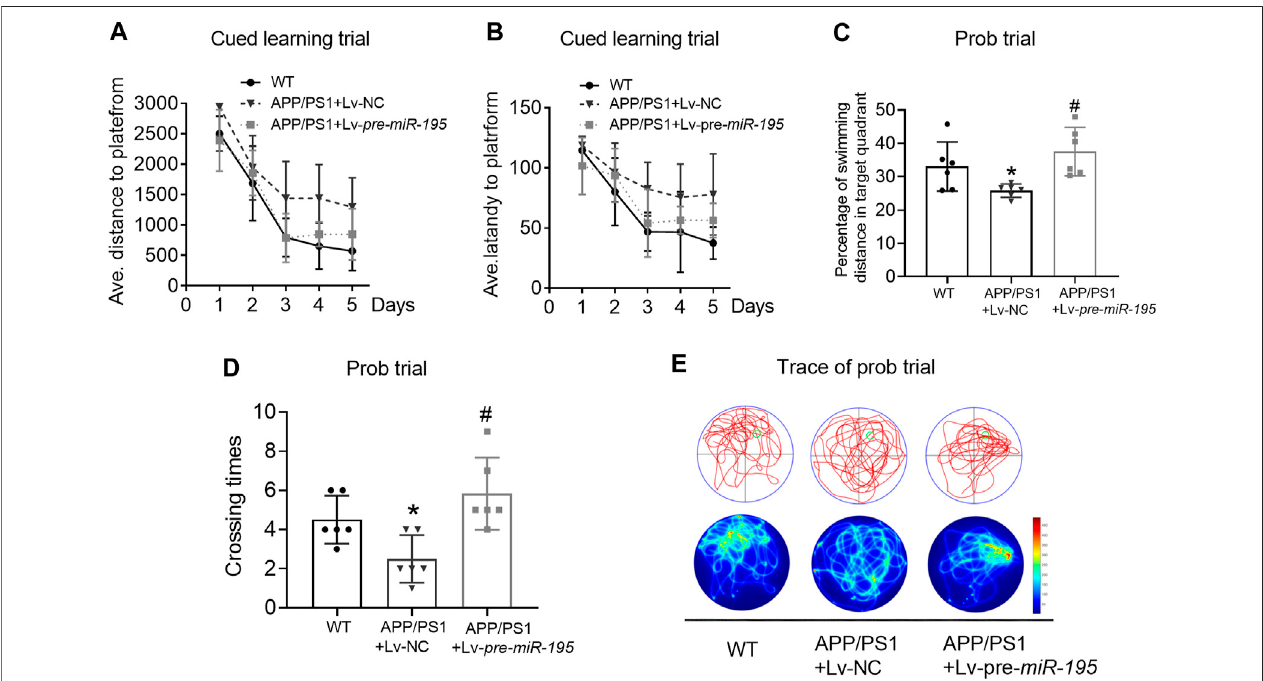
FIGURE5| MiR-195 attenuatesthedeclinedlearningandmemoryinAPP/PS1miceafterbraininjectionofLv-pre- miR-195 for3M (A) Averagedistancetoplatform after Lv- pre-miR-195 injectionfor3M. n (cid:2) 6forWT,Lv-NCandLv-pre -miR-195 group (B) Averageescape latencytoplatformaftertreatmentofLv-pre -miR-195 for3M. n (cid:2) 6 for WT, Lv-NC and Lv- pre-miR-195 group (C) Percentage of swimming distance in the target quadrant relative to the total distance of the pool during probe trial. * p < 0.05vs.WT, n (cid:2) 6. # p < 0.05vs.Lv-NC, n (cid:2) 6 (D) Numberoftimestocrossthetargetplatform duringprobetrial.* p < 0.05vs. WT, n (cid:2) 6.# p < 0.05vs. Lv-NC, n (cid:2) 6 (E) Representative path tracings and heat maps of the probe test on day 6 in the MWM test for each group.